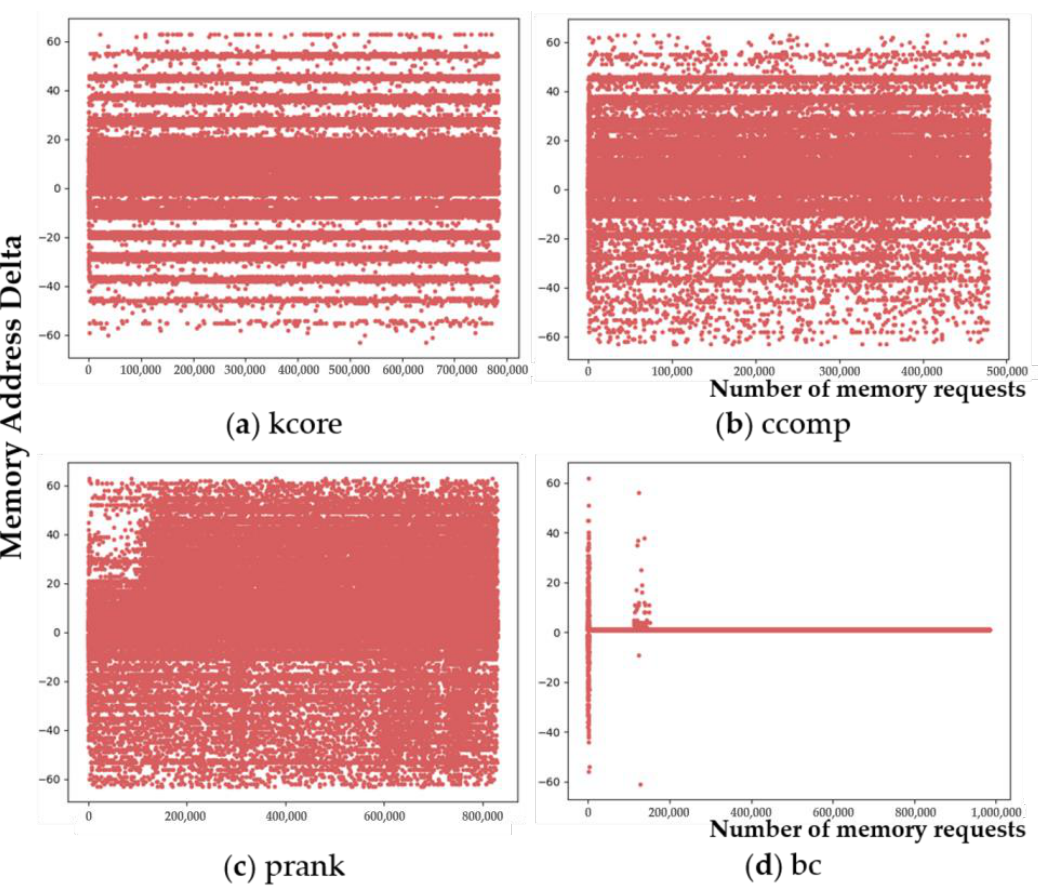
Figure 8. Memory access patterns of graph processing.